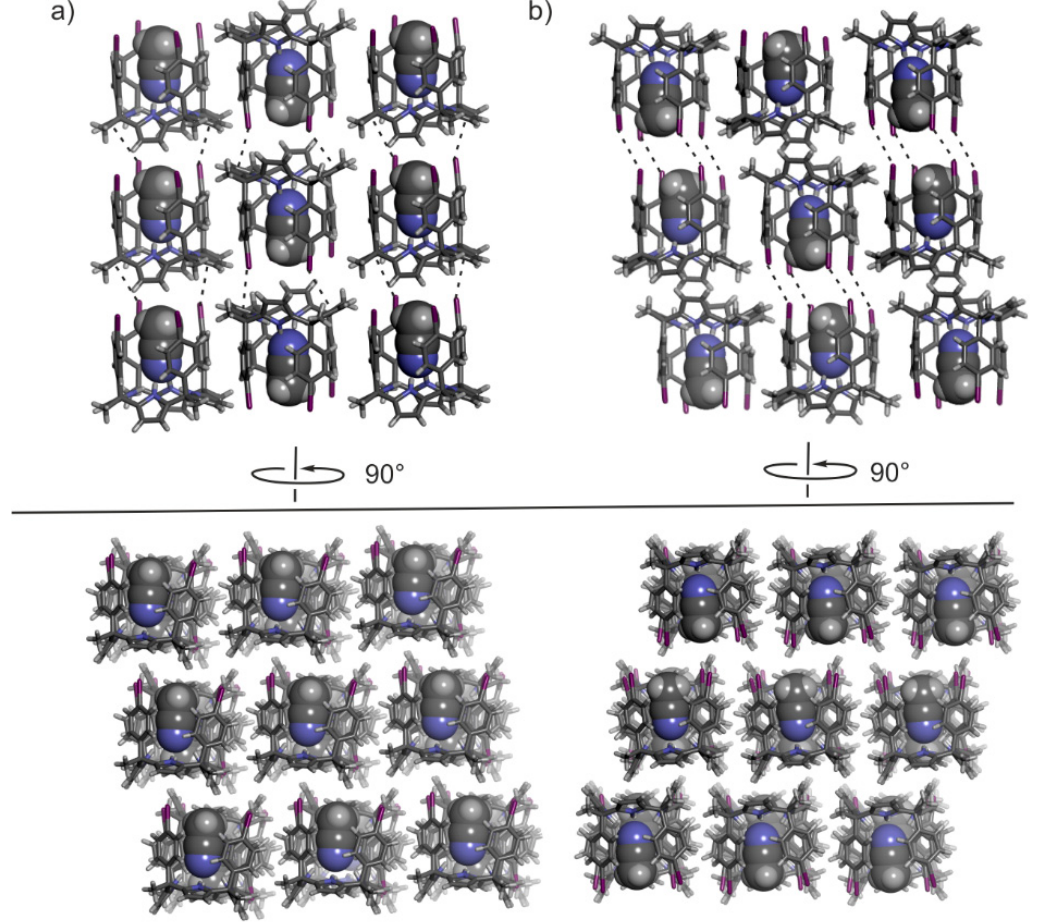
Figure 3. Cubes (3 × 3) of 2D layers stacks of CH 3 CN@calix[4]pyrrole inclusion complexes forming the 3D crystal lattices of polymorphs A ( a ) and B ( b ) viewed from two adjacent faces (90° rotation). The calix[4]pyrroles are shown in stick representation and the included acetonitrile as CPK models. In the top panel, halogen-bonding interactions are denoted with dashed black lines.